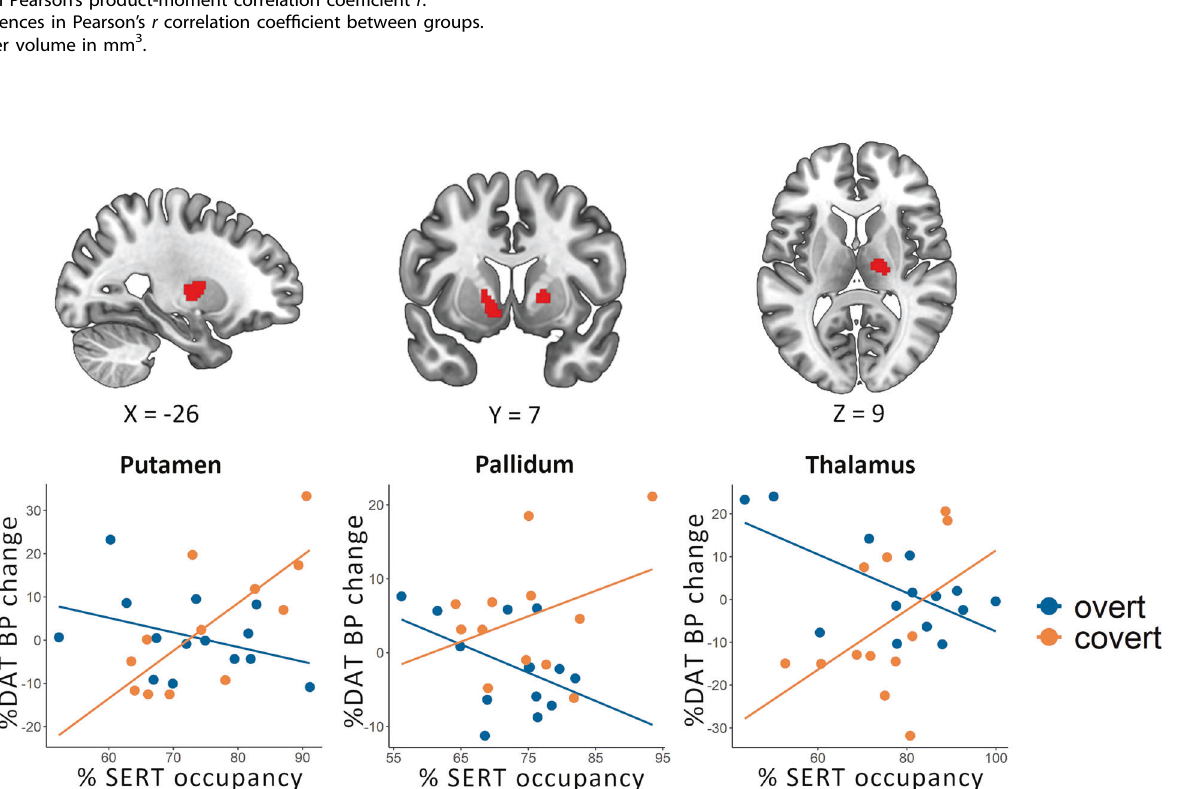
All analyses are at p < 0.05 with age and sex as covariates. MNI Montreal Neurological Institute. a Partial Pearson ’ s product-moment correlation coef fi cient r . b Differences in Pearson ’ s r correlation coef fi cient between groups. c Cluster volume in mm 3